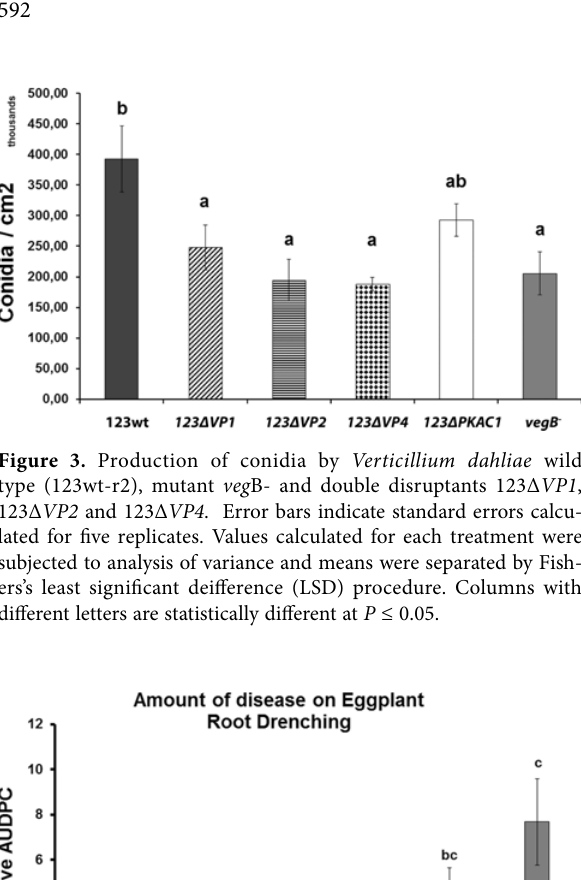
123Δ VP4 on pathogenicity of V. dahliae in comparison with the wild type strain.